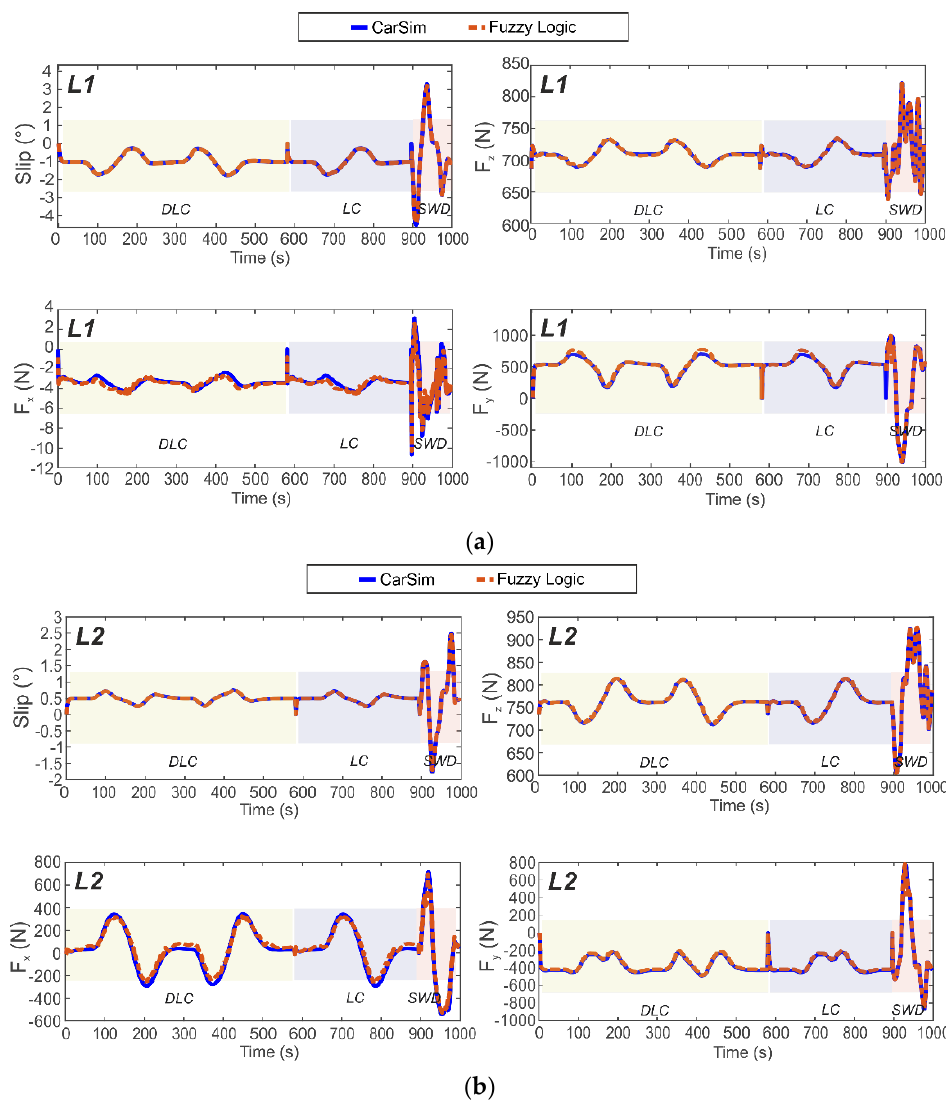
Figure 11. Simulation results for tire`s maneuverings at 30 km/h. ( a ) Steered axle, wheel L1 ( b ) Powered axle, wheel L2. Table 1. Normalized error of tire parameters simulation